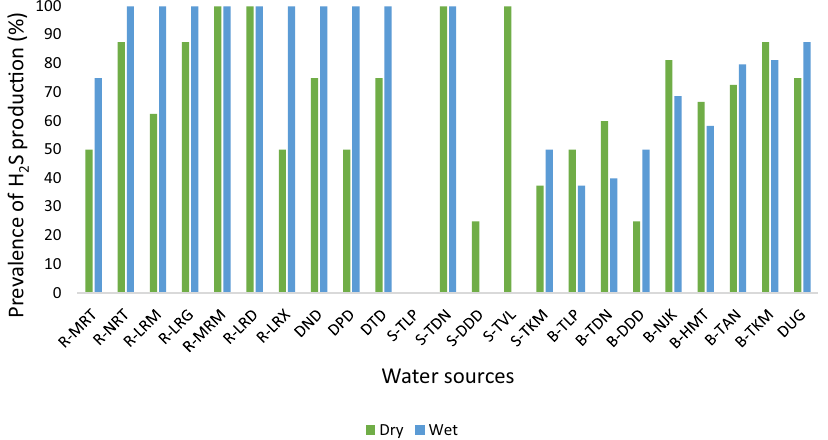
Figure 3. Prevalence of H 2 S production in water samples from various water sources in dry and wet